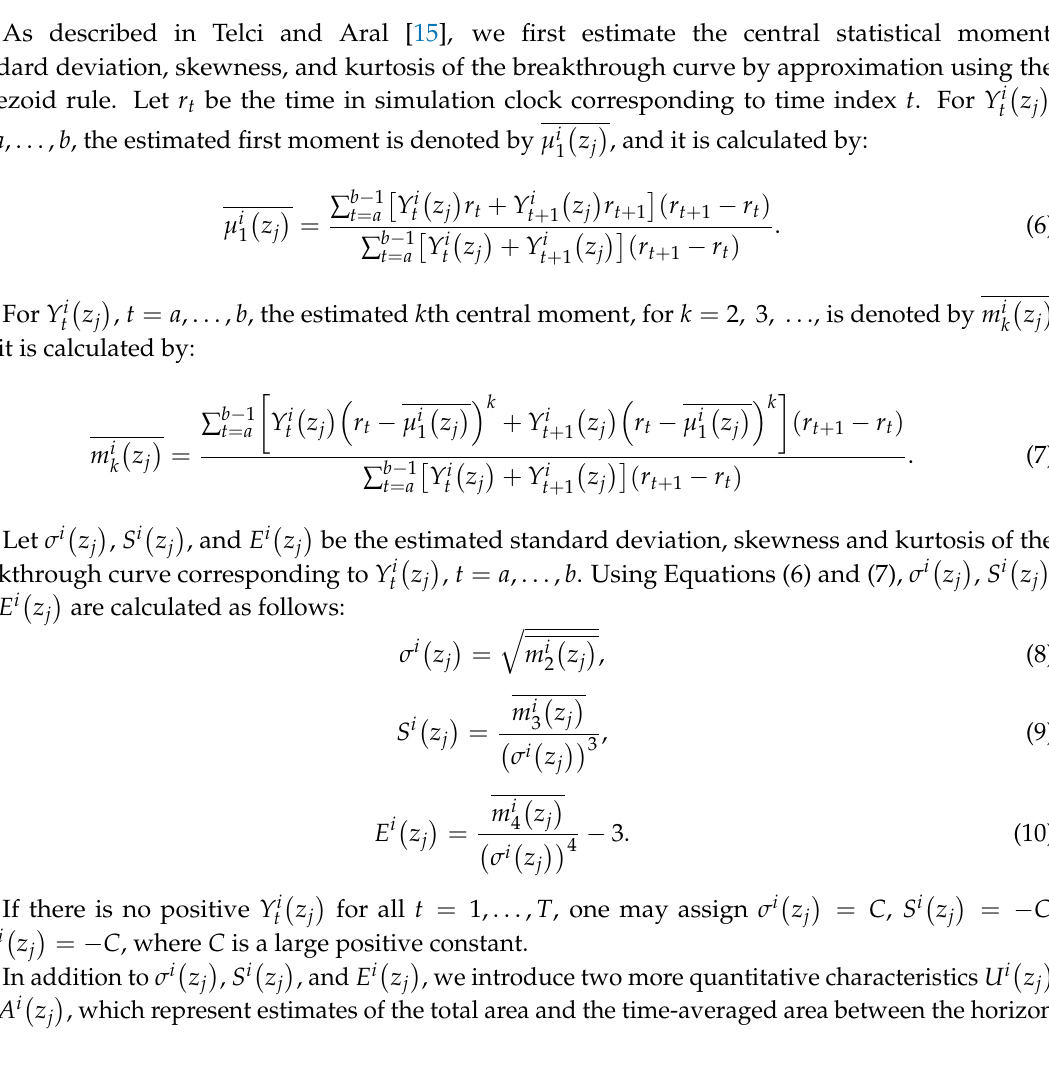
Figure 3. Example of non-zero Y i